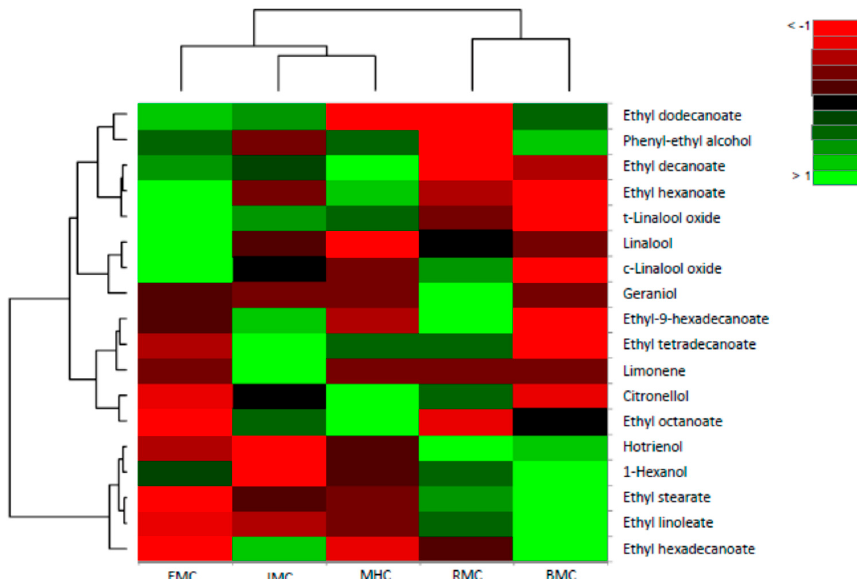
Figure 3. Heatmap of the volatile aroma compounds identified in grape brandy samples of Muscat cultivars without the addition of enzymes (control) based on relative abundance differences of compounds.